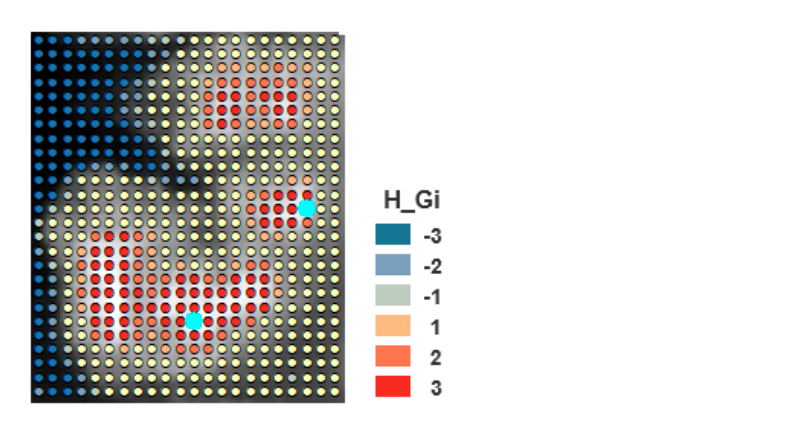
Figure 27. The distribution map for the fifth dataset using our proposed approach.